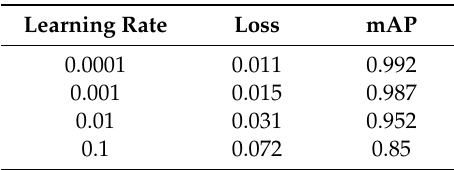
Table 6. Learning rate test